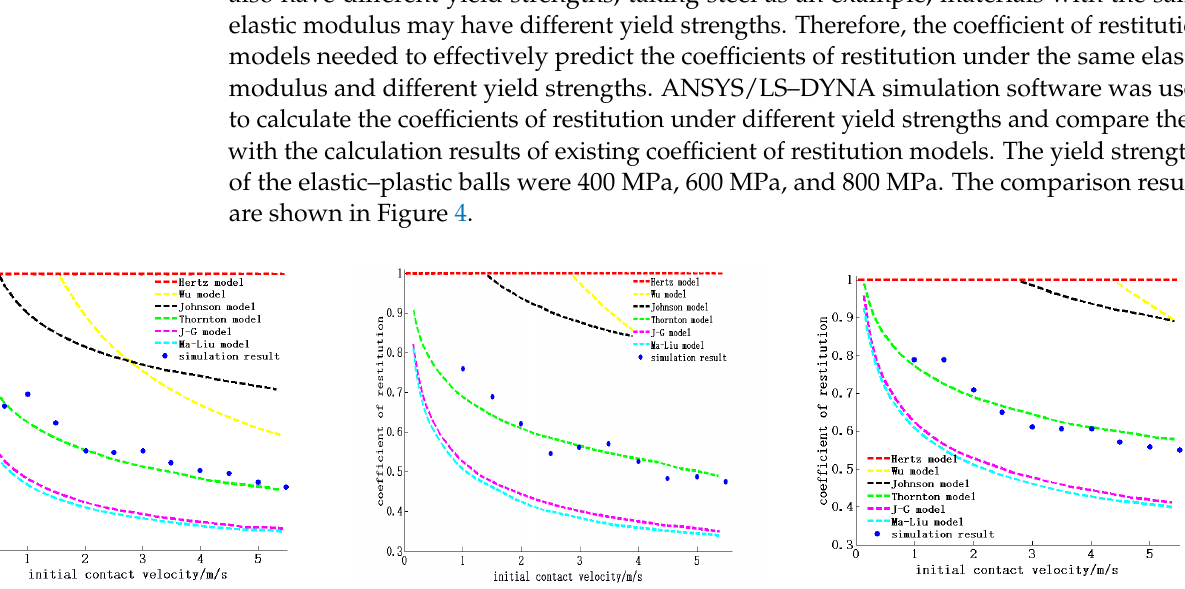
Figure 3. Mesh division during ball–plate collision: ( a ) matrix meshing, ( b ) ball meshing, ( c ) three- dimensional model of ball–plate collision.